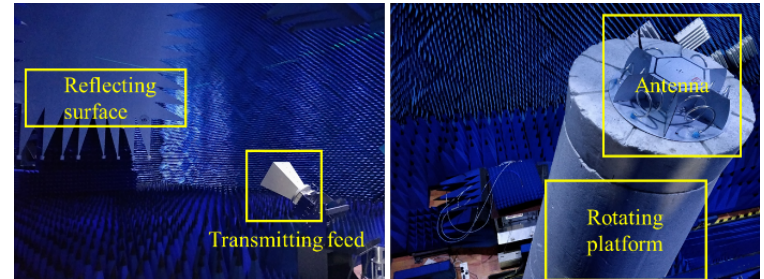
Figure 10. Antenna detection platform in microwave anechoic chamber.